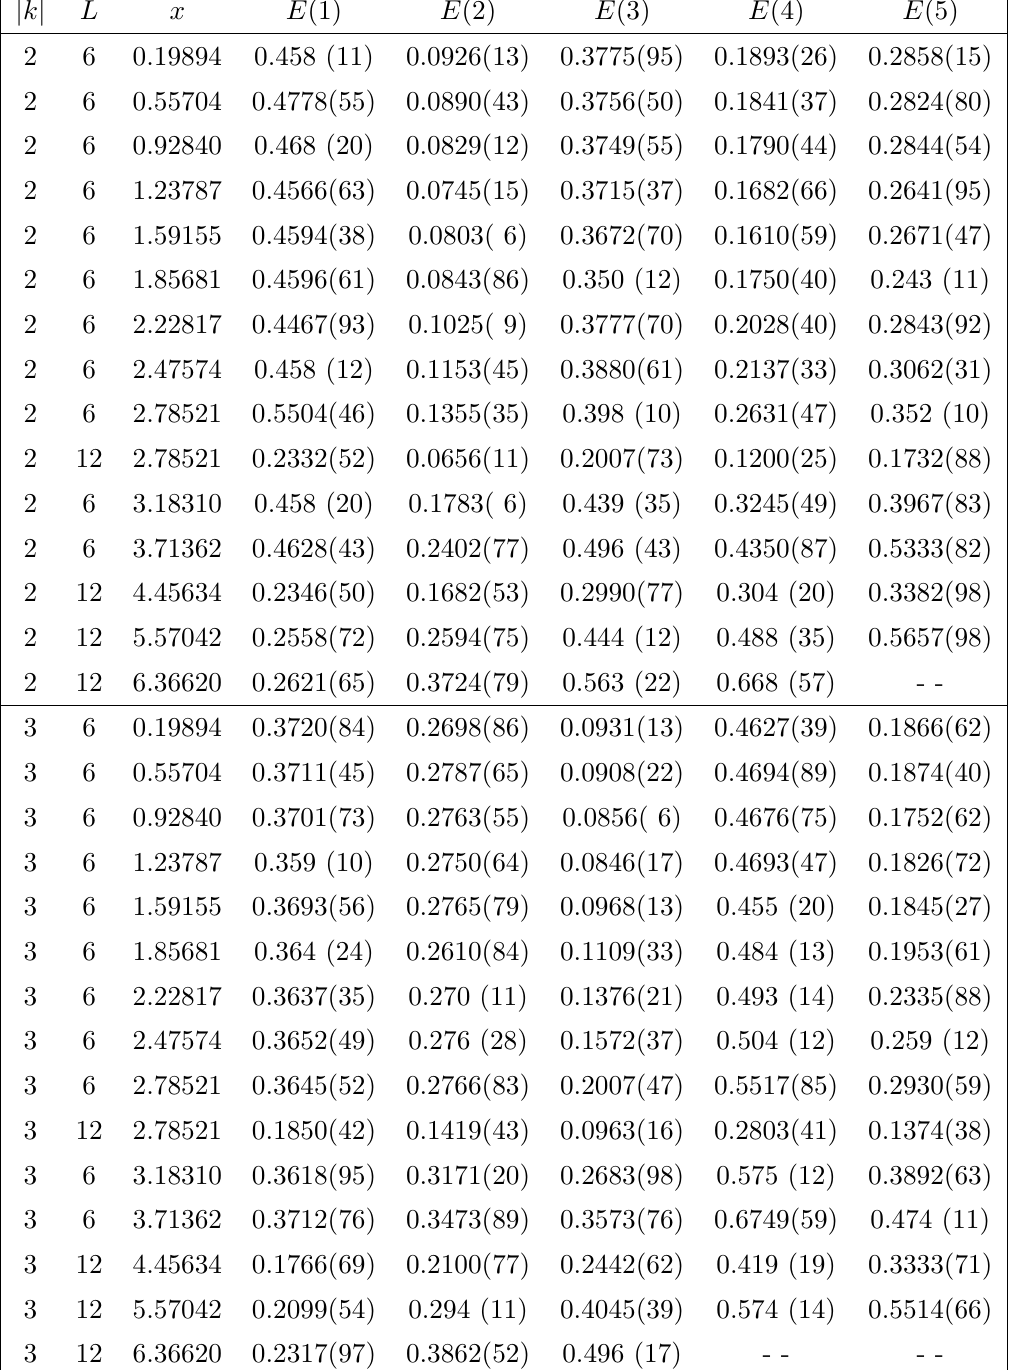
Table 6. SU(11) torelon energies (in lattice units). The states are labelled by the value of the electric (cid:13)ux